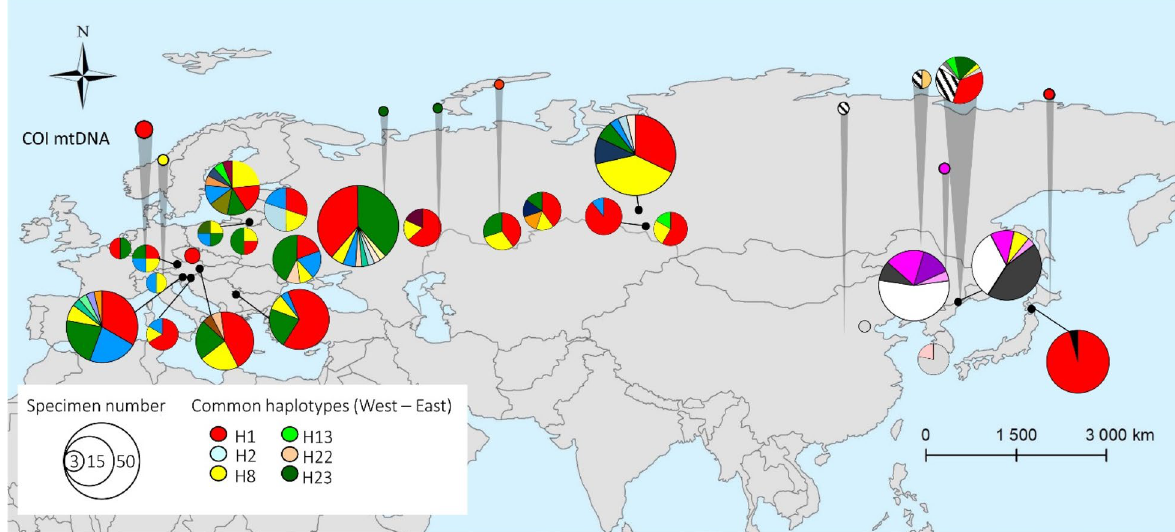
Figure 6. Geographical distribution of historical and modern haplotypes of Phyllonorycter issikii found across the Palearctic. The data on the haplotype diversity of Ph. issikii in the modern range is in agreement with our previous study 20 . Each pie chart represents a country, except Russia where nearest locations are merged into one pie chat. Each color of pie charts refers to one of the haplotypes found across the Palearctic; the haplotypes sequenced in archival insects are shown in 10 pie charts with grey callouts. Six haplotypes are present both in the East and West Palearctic and are found in both modern and archival samples (see legend); the historical haplotypes that are not present in the modern range are counted altogether into one sector of a circle diagram with line shading. The exact geographical location of historical haplotypes can be found in Tables S5, S6. The map was generated using ArcGIS 9.3 (Release 9.3. New York St., Redlands, CA. Environmental Systems Research Institute, http:// www. esri. com/ softw are/ arcgis/ eval- help/ arcgis-